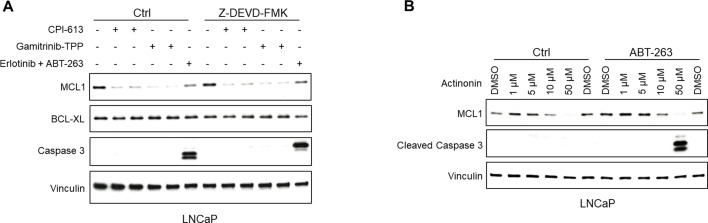
Mitochondria-targeted agents increase caspase-independent MCL1 degradation and synergize with BCLXL/BCL2 inhibitor to induce apoptosis.(A) LNCaP cells were pretreated with caspase inhibitor Z-DEVD-FMK (20 μM) for 1 hr, followed by treatment with CPI-613 (200 μM), gamitrinib-TPP (5 μM), or erlotinib (10 μM) and BCLXL/BCL2 inhibitor ABT-737 (5 μM) for 5 hr. Efficacy of caspase block by Z-DEVD-FMK was confirmed by blotting for caspase 3. (B) LNCaP were treated with actinonin with or without BCLXL/BCL2 inhibitor ABT-263 (500 nM) for 5 hr.